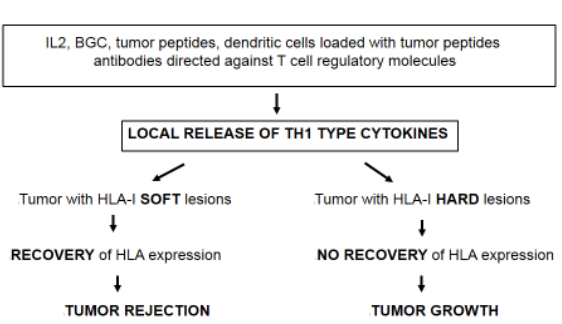
Figure 1. Recovery of major histocompatibility complex (MHC)/HLA-I antigens in tumors. Different treatments, including IL-2, Bacillus Calmette–Guérin (BCG), or tumor peptides, can boost anti-tumor T cell-mediated responses. Currently, monoclonal antibodies against “immune checkpoint” molecules are also being actively used in the clinic. All these therapies can modify the tumor microenvironment and induce the release of TH1 type cytokines. HLA-I deficient tumors can upregulate HLA-I expression depending on the nature of the underlying molecular alteration. If the defect is reversible/“soft”, tumor or metastatic lesion can be rejected after cytokine-mediated recovery of the antigen presentation capacity. If the alteration is irreversible/“hard”, tumor or metastasis will remain HLA-I negative and, most likely, will escape T cell responses and continue to grow.